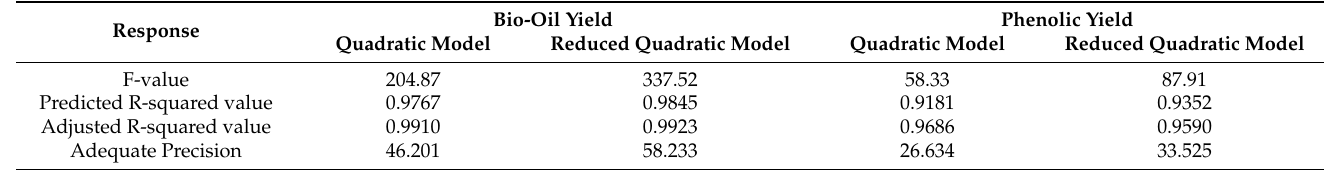
Table 8. Comparison between quadratic model and reduced quadratic